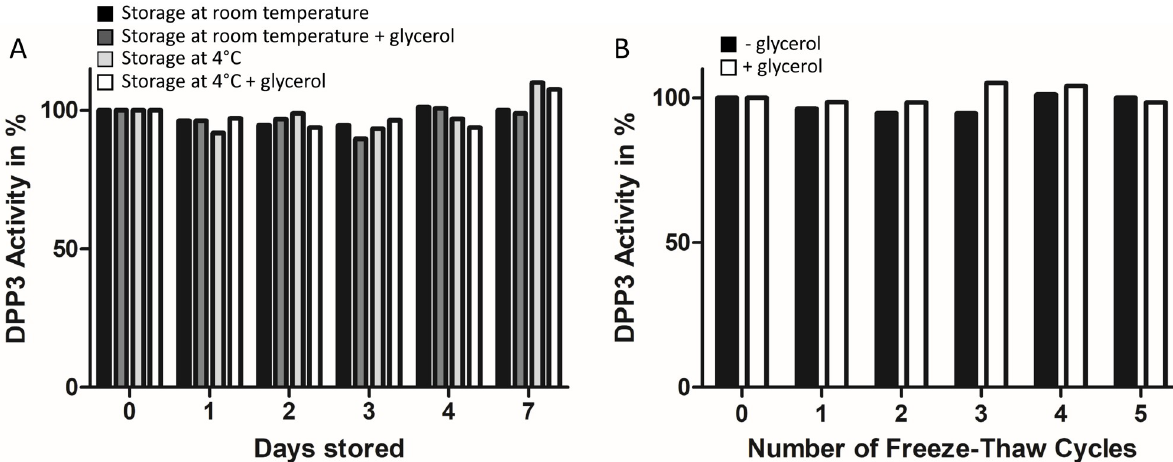
Fig 5. Freeze-thaw stability and storage stability of native hDPP3. (A) Purified and sterile filtered DPP3 (200 μ g/mL) in storage buffer in presence or absence of 10% glycerol was stored for 1 to 7 days at 4˚C or room temperature. Activity of stored DPP3 was determined via DPP3-ECA. Activity of DPP3 stored for a period of 7 days at -20˚C was set as 100%. Black bar: DPP3 stored at room temperature in phosphate buffer, dark-grey bar: DPP3 stored at room temperature in presence of glycerol, light-grey bar: DPP3 stored at 4˚C in phosphate buffer, white bar: DPP3 stored at 4˚C in presence of glycerol. (B) Purified and sterile filtered DPP3 in 12mM NaH 2 PO 4 , 400 mM NaCl, pH 7.4 (black bar) or in 12mM NaH 2 PO 4 , 400 mM NaCl, 10% glycerol (white bar), pH 7.4 was applied to 1 freeze-thaw cycles in 24h. All aliquots were stored at -20˚C until activity determination via DPP3-ECA. Activity of protein stored at -20˚C for 5 days (0 freeze-thaw cycles) was set as 100%.